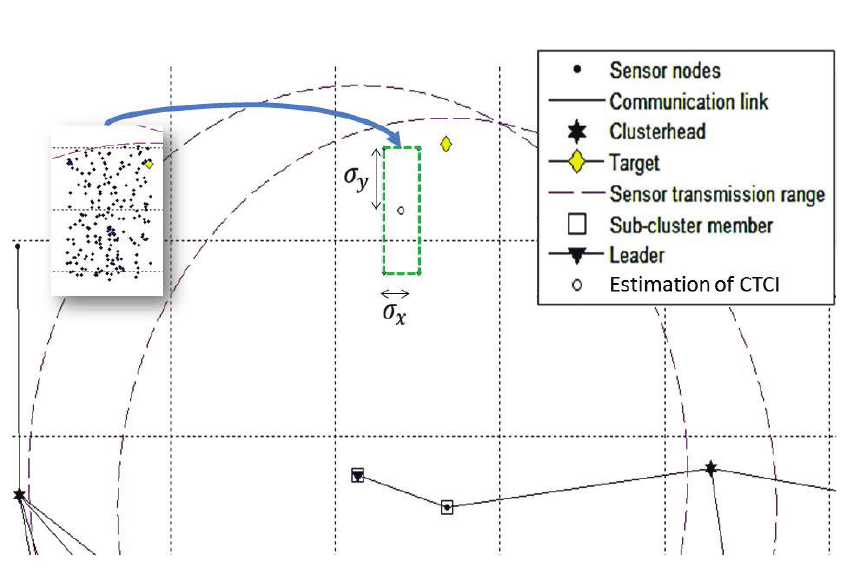
Figure 12. The stochastic distribution of position